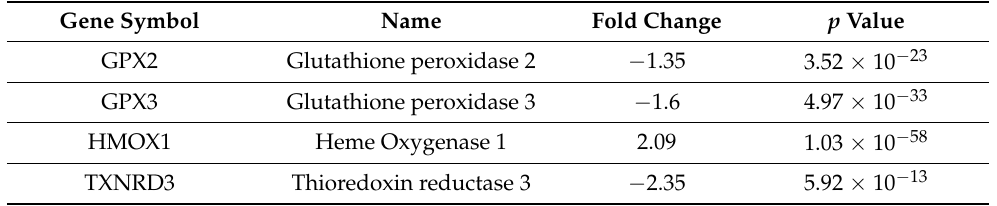
Table 1. ROS signaling associated